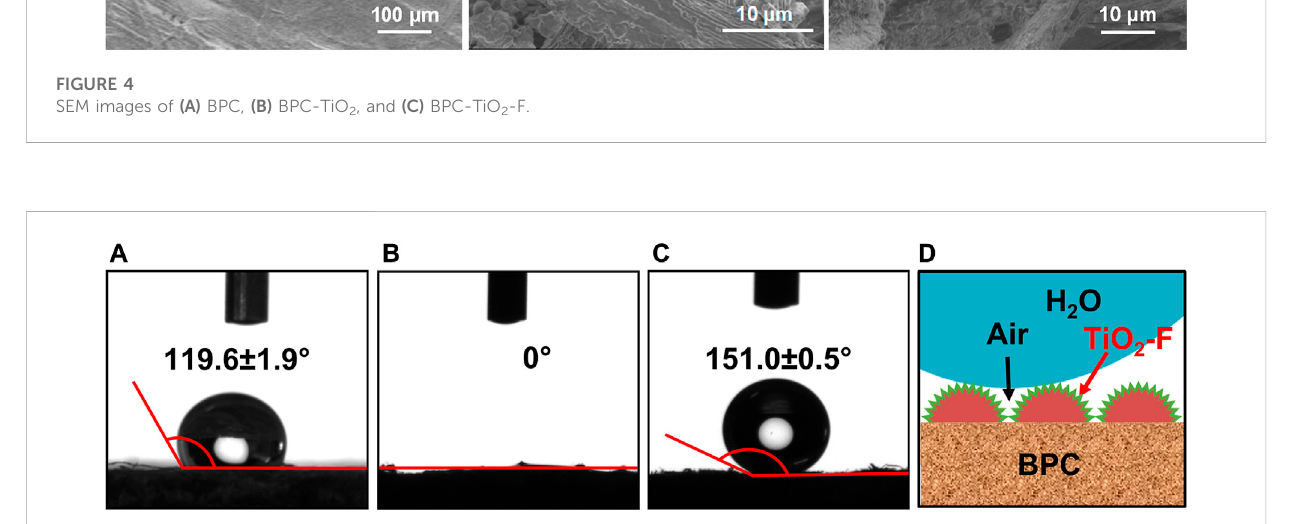
FIGURE 5 Water contact angle of (A) BPC, (B) BPC-TiO 2, and (C) BPC-TiO 2 -F. (D) Scheme of a water drop on the surface of BPC-TiO 2 -F in a combined Wenzel – Cassie